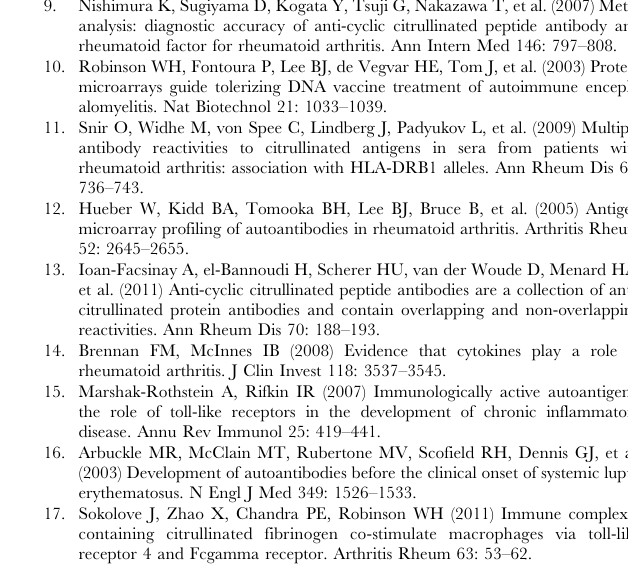
Figure S2 Alternative demonstration of values of bio- markers contributing to imminent RA biomarker pro- file. Scatter plots demonstrate actual values and range of